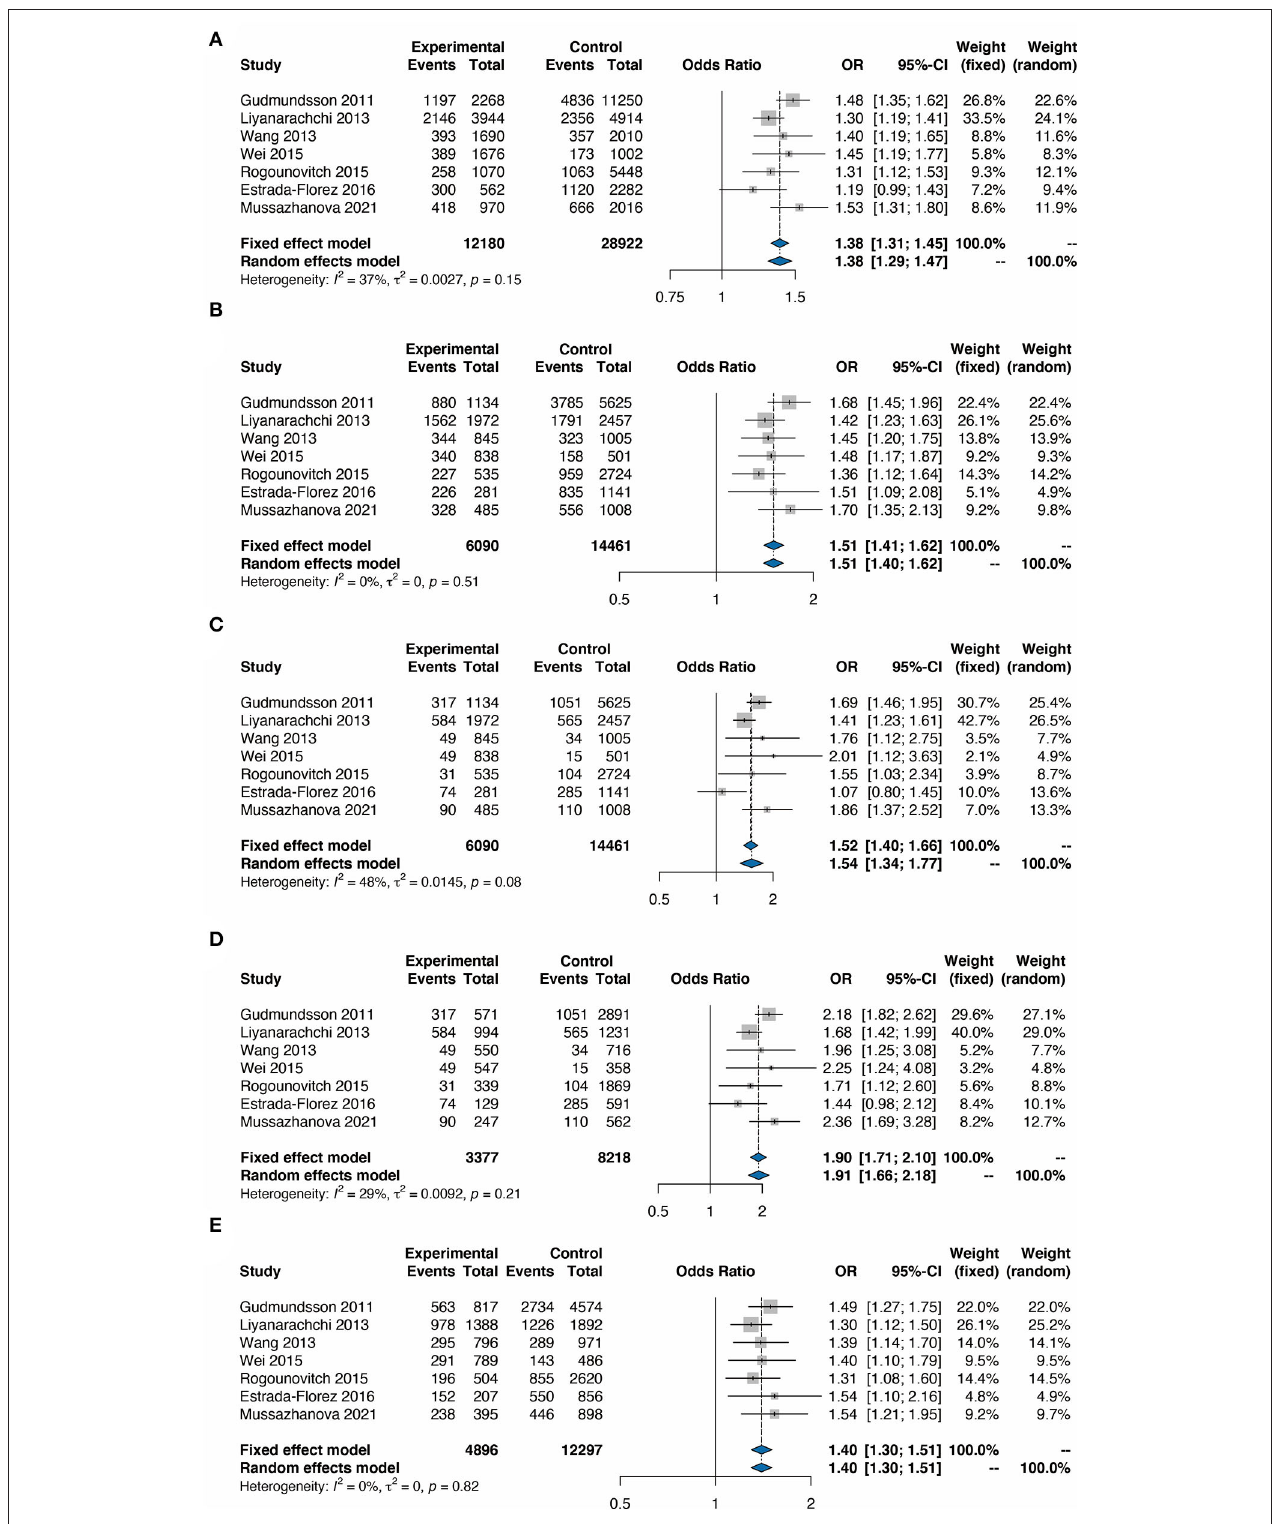
FIGURE 2 | Forest plots for the meta-analysis of rs2439302 polymorphism and the risk of TC. (A) G vs. C (allele model). (B) GG plus CG vs. CC (dominant model). (C) GG vs. CC plus CG (recessive model). (D) GG vs. CC (homozygous model). (E) GC vs. CC (heterozygous model). OR, odds ratios; CI, confidence interval.